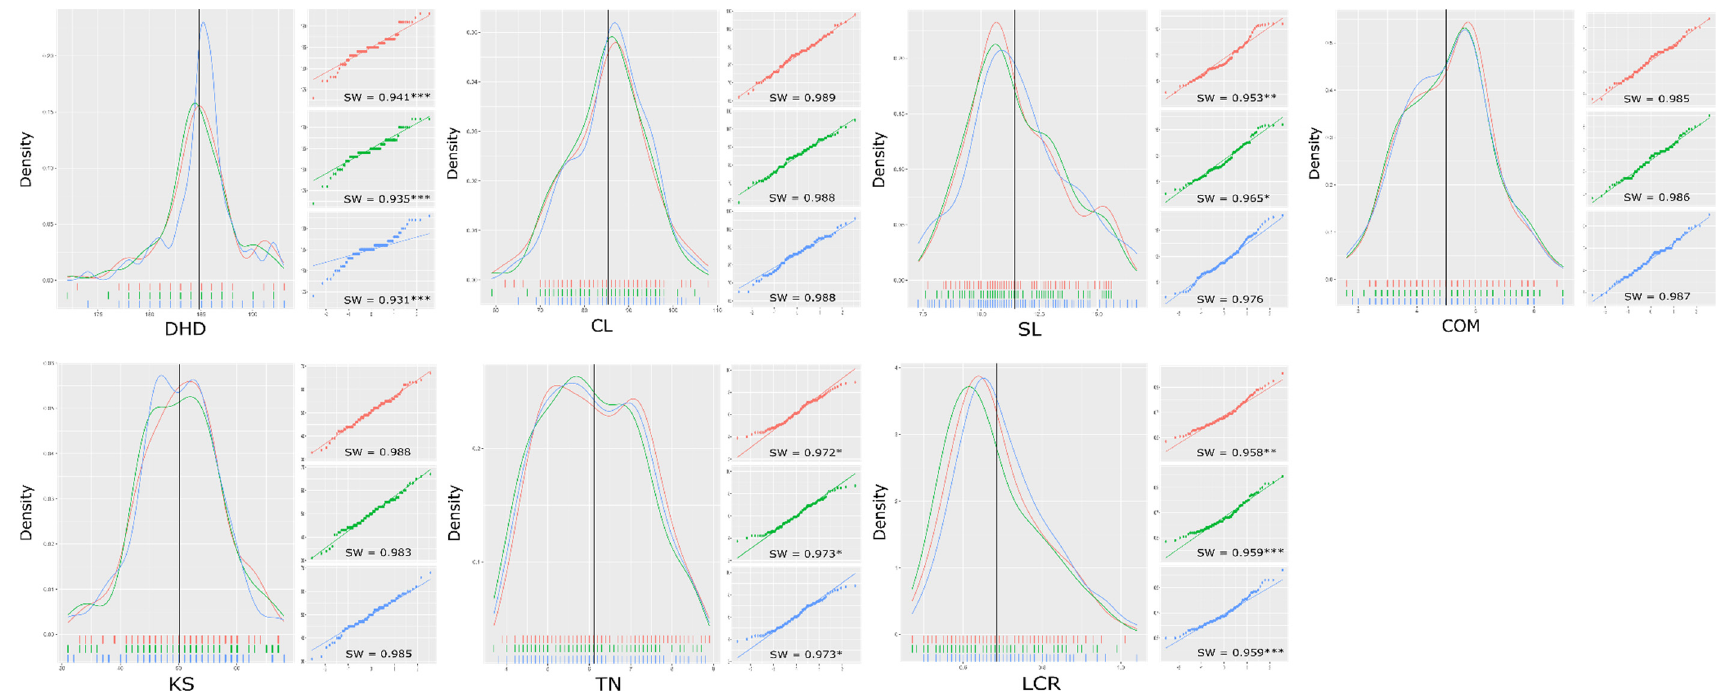
Figure 2. Comparison of density and probability distribution of yield potential traits across three years. DHD, days to heading date; CL, culm length; SL, spike length; COM, compactness; KS, kernels per spike; TN, number of tillers; LCR, length of center rachis. Red, green, and blue colors indicate data from 2017, 2018, and 2019, respectively. A black vertical line indicates the mean value of the three years. SW indicates the P -value from the Shapiro–Wilk test, and an asterisk indicates significance (*, **, and *** at P ≤ 0.05, P ≤ 0.01, and P ≤ 0.001 levels, respectively).